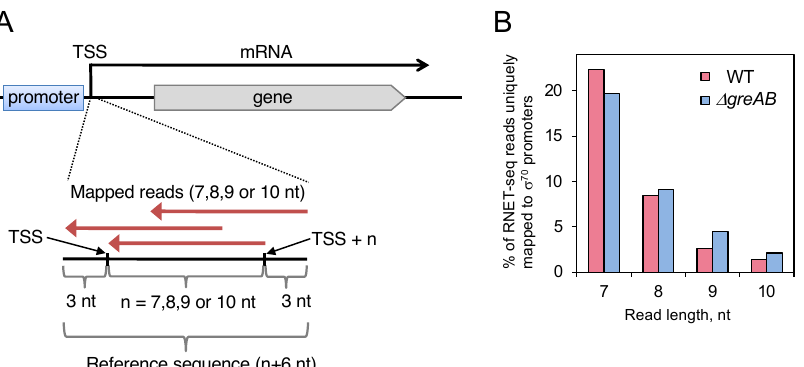
Figure 2. RNET-seq analysis for abortive transcription and pausing during initiation. ( A ) The short RNET-seq reads of a fixed length (7, 8, 9 or 10 nt long) were mapped to the TSS downstream of 775 σ 70 promoters [27]. In the mapping procedure, we allowed ± 3 nt positional fluctuations of TSS. Since the 7–10 nt reads were too short to be uniquely and precisely mapped to the entire E. coli genome, we extracted the TSS downstream sequences from the genome as reference sequences enabling us to uniquely map these short reads to the reference sequence library (see Materials and Methods for more details). Mapped short reads with the direction opposite to transcription are schematically shown by arrows. Using this procedure, ( B ) The short reads of each length, with sense orientation to mRNA genes, were mapped to the special reference by Blat program [28]. The uniquely mapped reads with perfect matches were selected for the analysis performed in the present study. The reads were obtained by RNET-seq of the nascent RNAs of E. coli WT and ∆ greAB cells